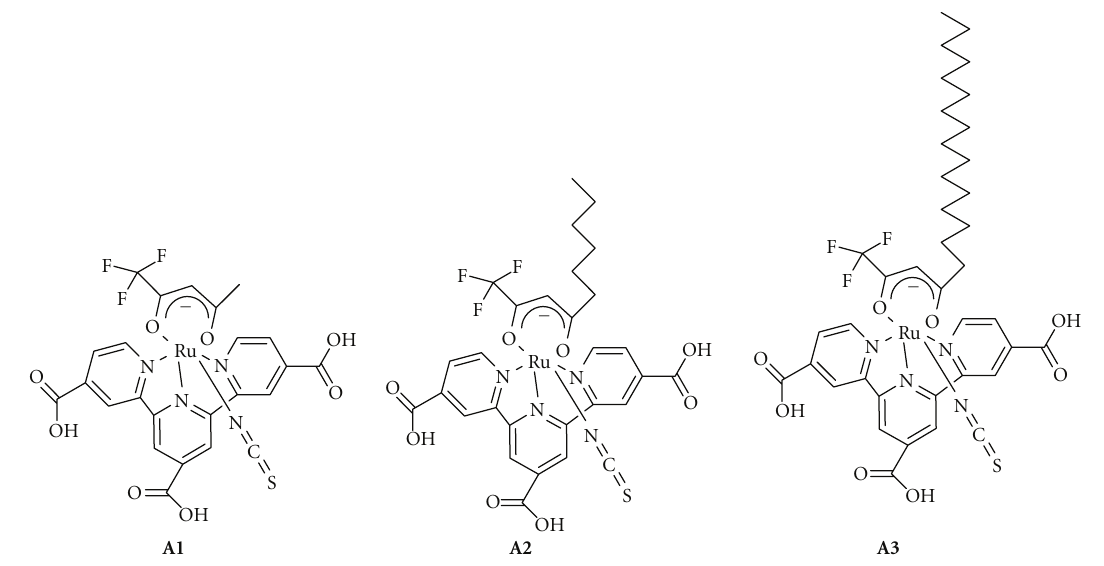
Figure 28: Molecular structures of complexes A1 , A2 , and A3 (taken from [48]).